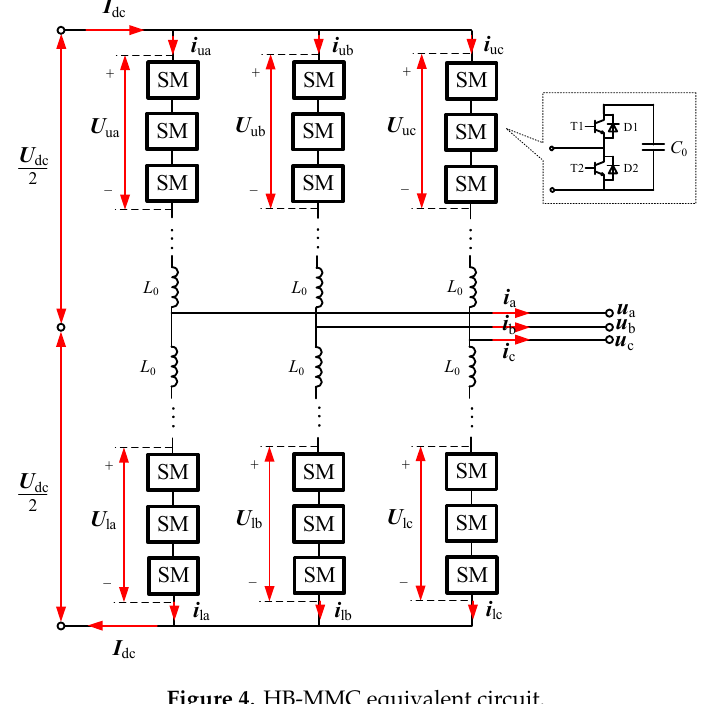
Figure 4. HB-MMC equivalent circuit.